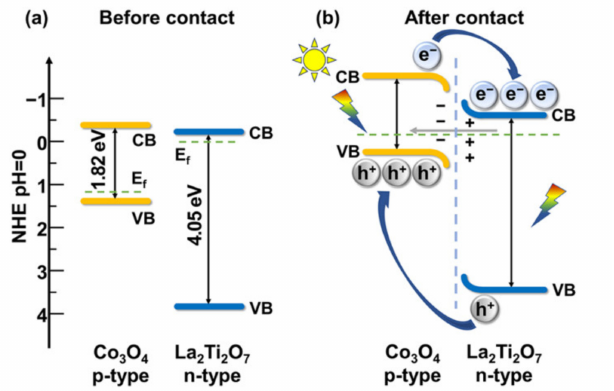
Figure 9. Band energy alignments of the composite ( a ) before contact and ( b ) after